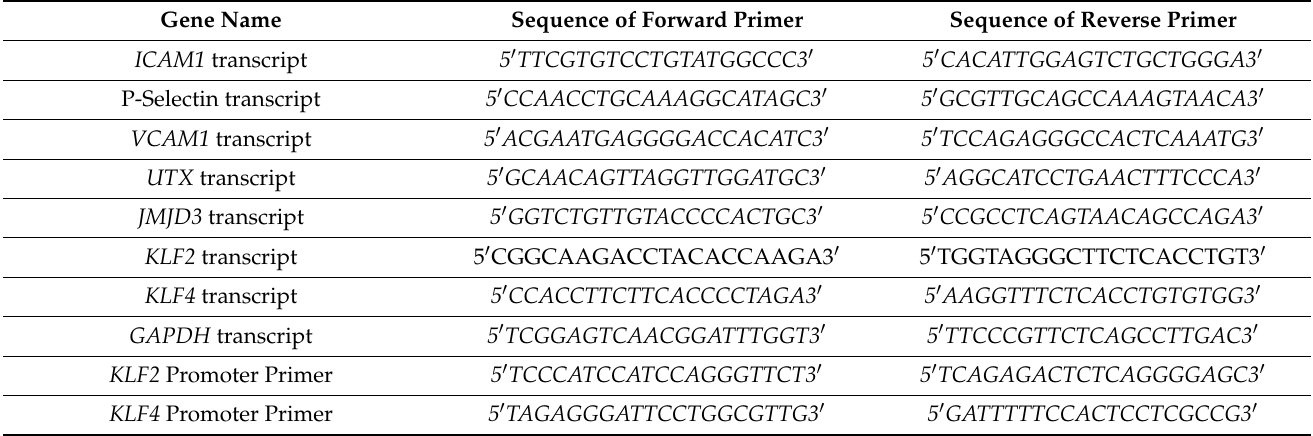
Table 1. Primer sequences for qPCR analysis of respective transcript or gene